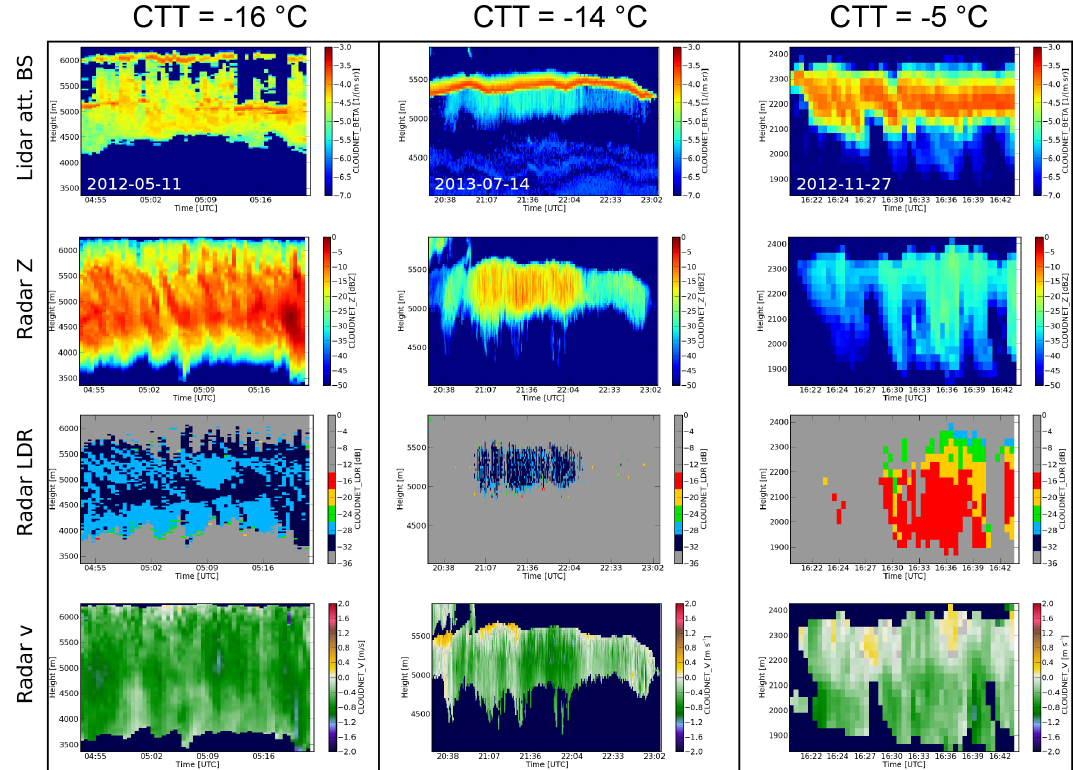
Figure 3. Three example case studies of mixed-phase clouds identified with the automated algorithm described in Sect. 3.